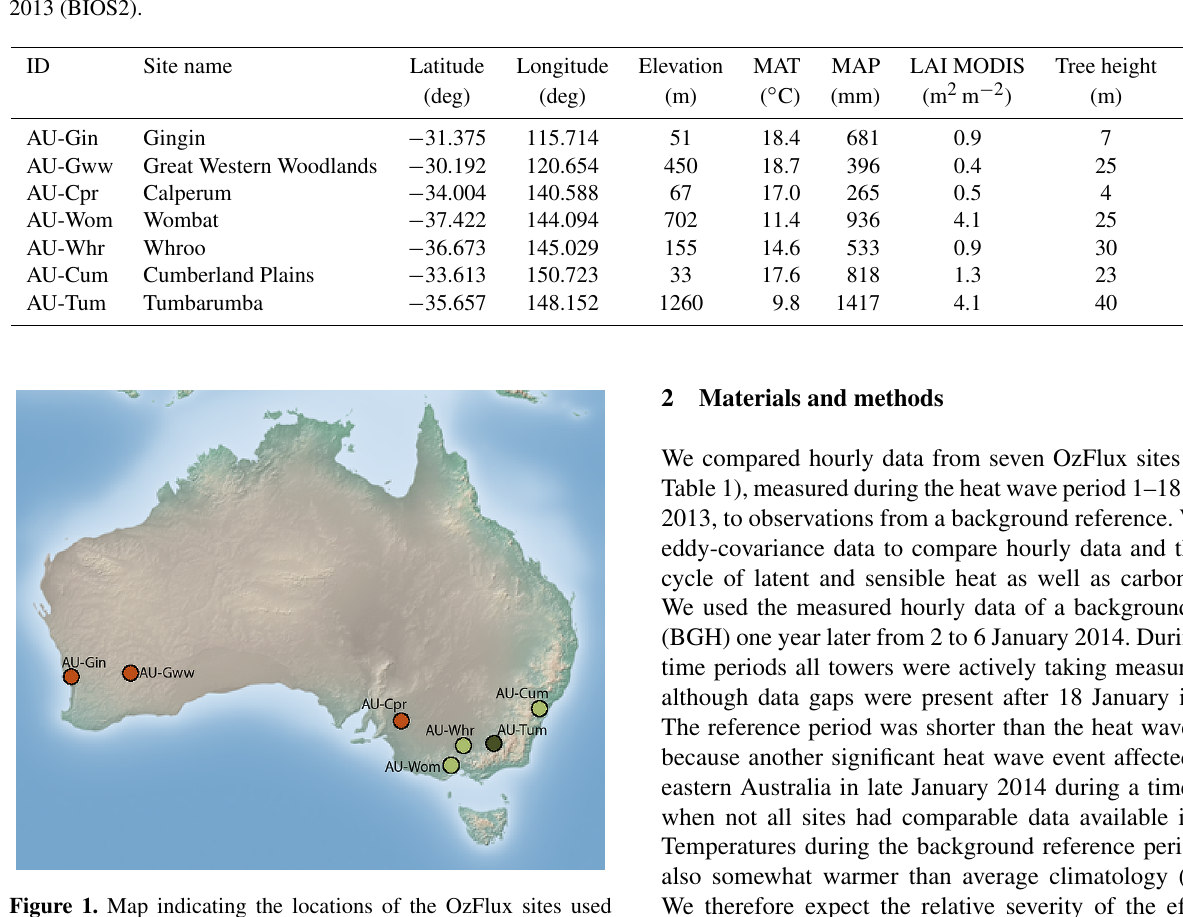
Table 1. List of OzFlux sites used in this study, abbreviations and site information. MW stands for Mediterranean woodlands, TW for temperate woodlands and TF for temperate forest. MAT and MAP are the mean annual temperature and precipitation for the years 1982– 2013 (BIOS2).